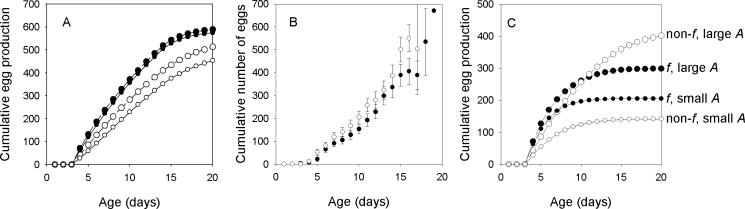
Cumulative Egg Production as a Measure of Reproductive Success of Females with and without the
Pgi-f Allele
(A) Cumulative egg production of
f (closed symbols) and non-
f females (open symbols) in small (continuous lines) and large patches (broken lines) in the absence of migration, calculated with the assumptions explained in
Materials and Methods.
(B) Cumulative egg production of females from new (closed symbols) and old populations (open symbols) in the experiment of Hanski et al. [
36].
(C) Same as (A) but with the effect of emigration included.